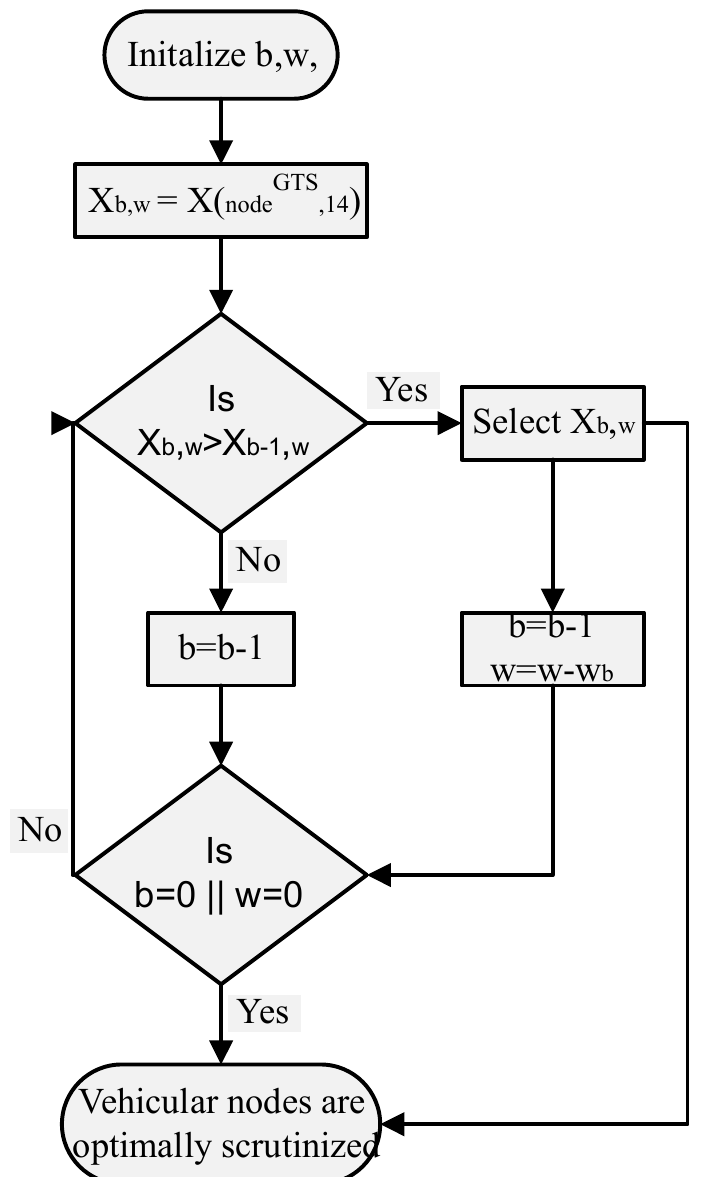
Figure 6. Optimal vehicular node selection